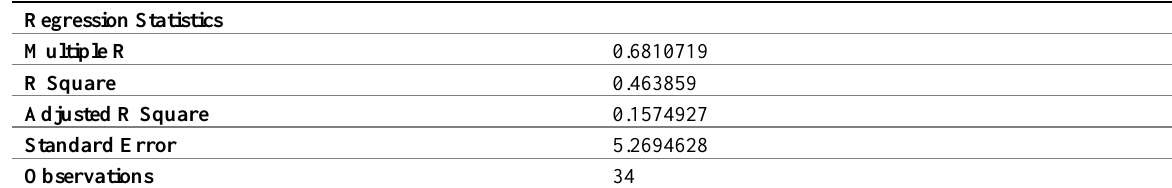
Table 16 : Regression Statistics (Mymensingh Division)